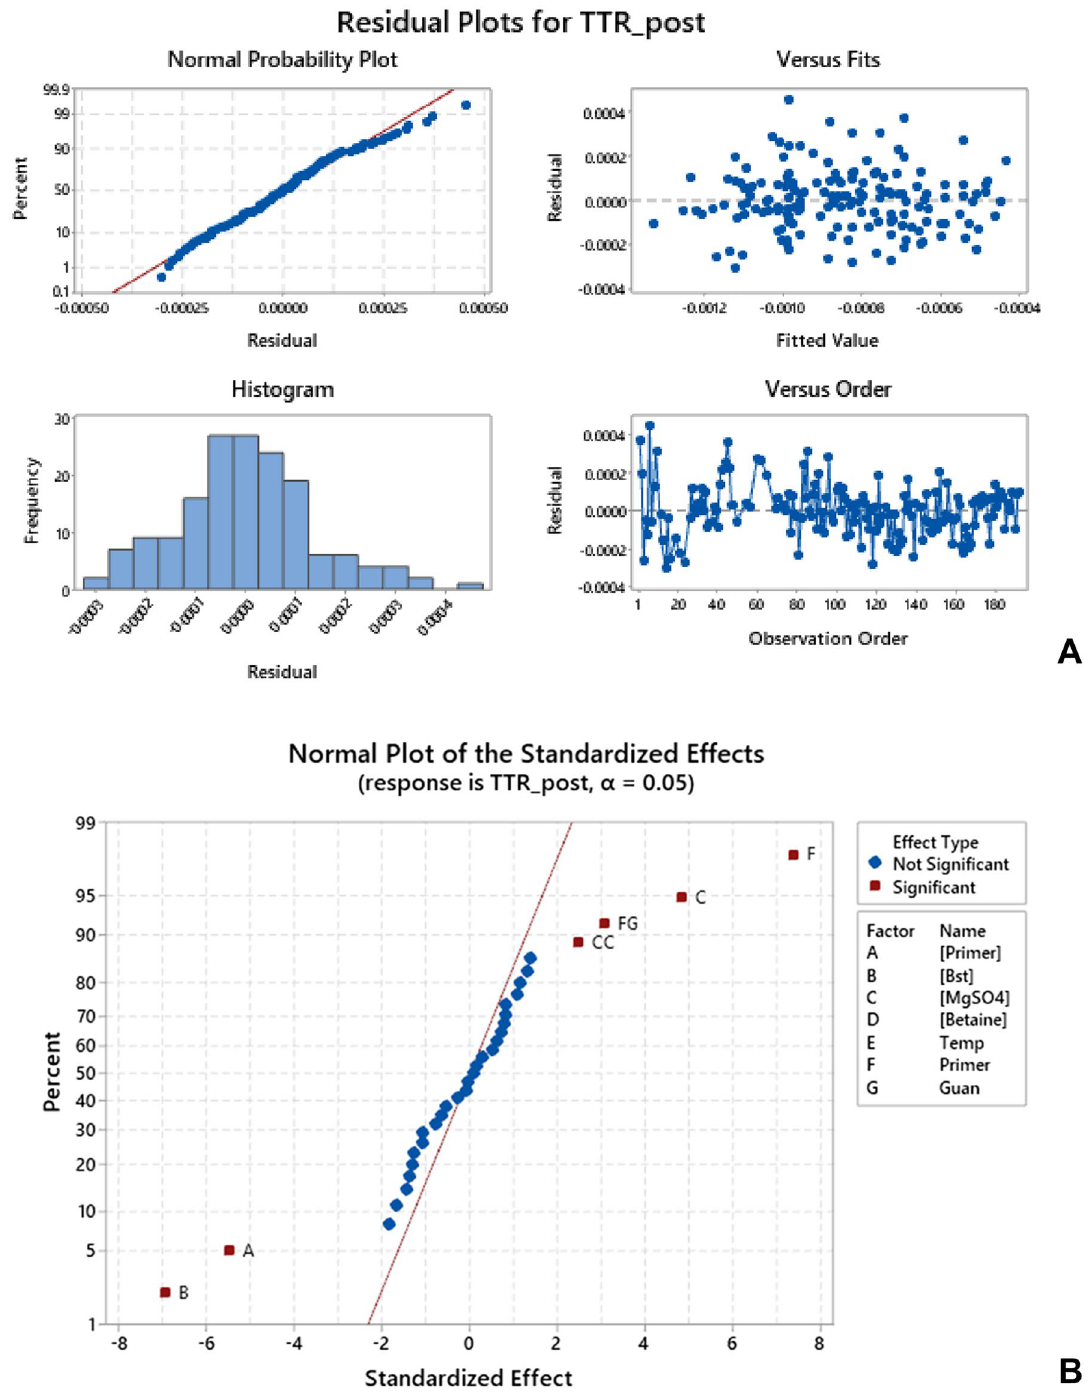
Figure 1. Analysis of the experiment results aiming to minimize the Time To Reaction (TTR) response of positive reactions, obtained with the software Minitab. In ( A ) Residual plots. The normal probability plot represents that the residuals analyzed are normally distributed. The histogram represents the distribution of the residuals. The residual versus fits plot shows that the residuals are randomly distributed, and the residual versus order plot indicates the residuals in the order that the data were collected, showing that the residuals are independent since there are no patterns in the observation order. ( B ) Normal probability plot with α = 0.05, where the significant factors, in order, were: primer sequence (F), Bst concentration (B), primer concentration (A), magnesium sulfate concentration (C), and the combination of primer sequence and adjust of hydrochloride guanidine pH